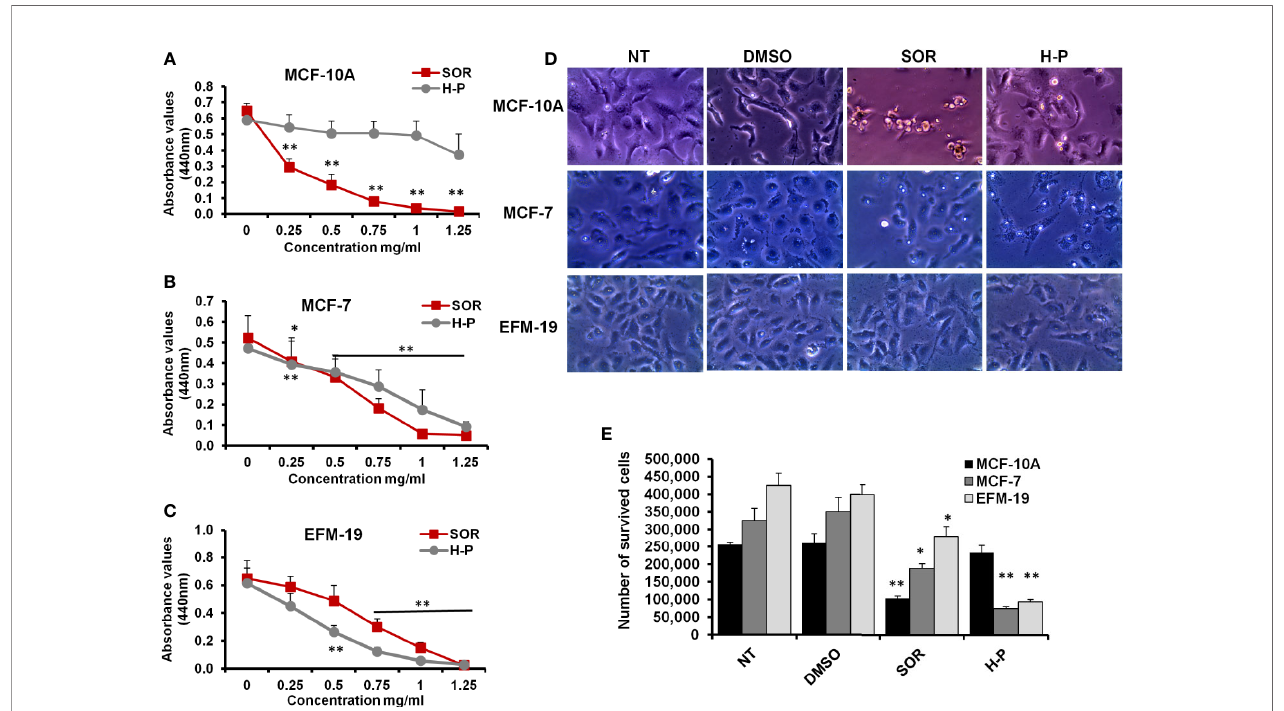
FIGURE 1 | The cytotoxic effects of SOR and H-P extract in normal human mammary cells and breast cancer cells. (A) The cell viability rate of MCF-10A cells treated with different concentrations of SOR or H-P extract that indicates the CC 50 of each one using WST-1 assay, n = 4. (B) The cell viability rate of MCF-7 cells treated with different concentrations of SOR or H-P extract that reveals the CC 50 of each inhibitor using WST-1 assay, n = 4. (C) The cell viability rate of EFM-19 cells treated with the same concentrations of SOR or H-P extract and revealed the CC 50 of each on other breast cancer cells using WST-1 assay, n = 4. Error bars indicate the standard deviation (SD) of four different replicates. (D) Representative inverted microscopy images of cells morphology two days upon treatment with SOR or H-P extract in comparison with DMSO-treated cells and untreated cells (NT). (E) The number of survived cells treated with either SOR or H-P extract, n = 3. Error bars indicate the SD of three independent experiments. A Student ’ s two-tailed t-test was used for the signi fi cance analysis of represented values. * p ≤ 0.05 and ** p ≤